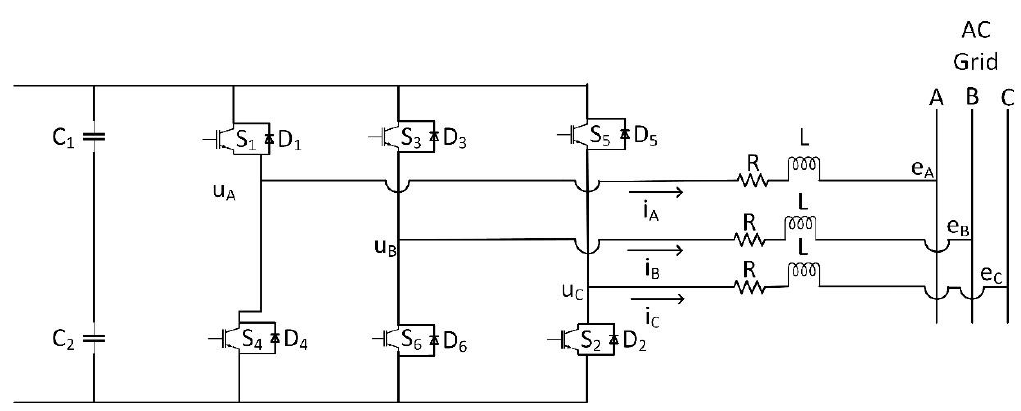
Figure 5. The configuration of the DC-AC inverter. Reprint with permission [29]; 2020, IEEE.